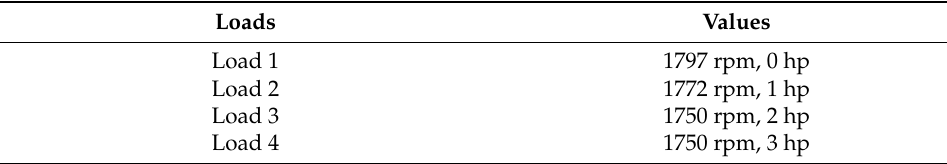
Figure 11. The experiment setup of rolling bearing. Table 8. Four different loads.